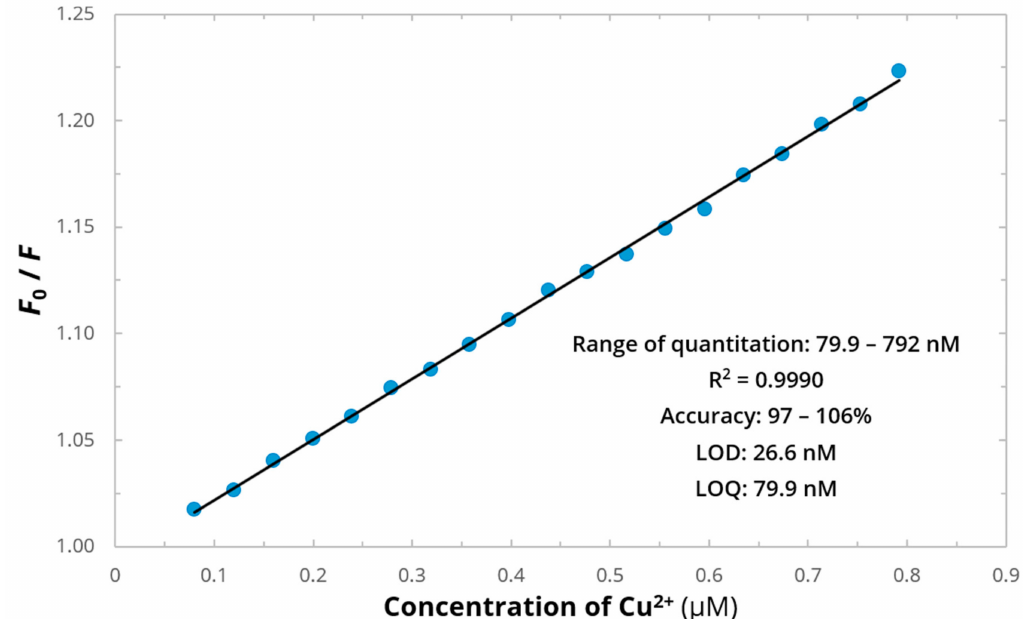
Figure 5. A calibration plot reflecting the relationship between the relative fluorescence decrease of EHYHQ (0.1 mM) and the concentration of Cu 2 + ions: the inset gathers analytical characteristics of the graph. F 0 values are shown as a mean value from 30 data points ( n = 30). LOD—limit of detection; F LOQ—limit of